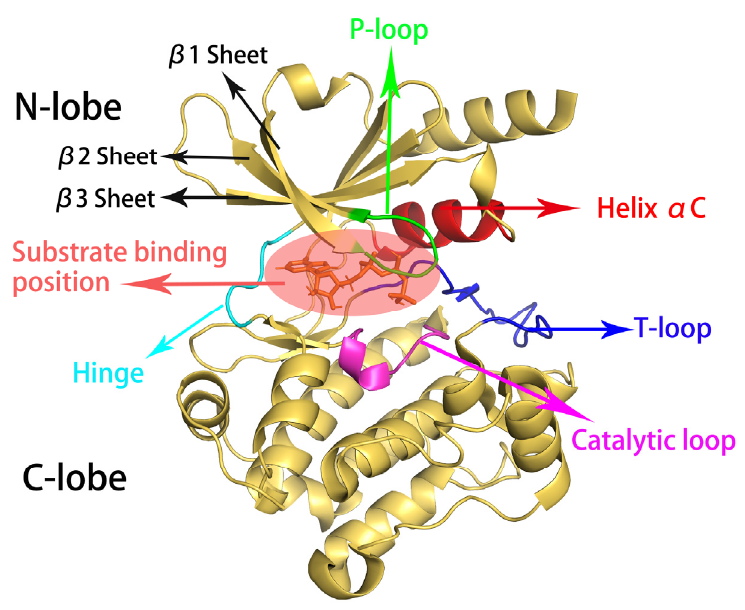
Figure 1. The cartoon representation of the kinase structural domain of PAK4. The P-loop is shown in green, Helix α C in red, Hinge in cyan, catalytic loop in pink, and T-loop in blue; the binding site of ATP is circled by a light red ellipse, and β 1- β 3 are indicated by arrows, respec- tively.